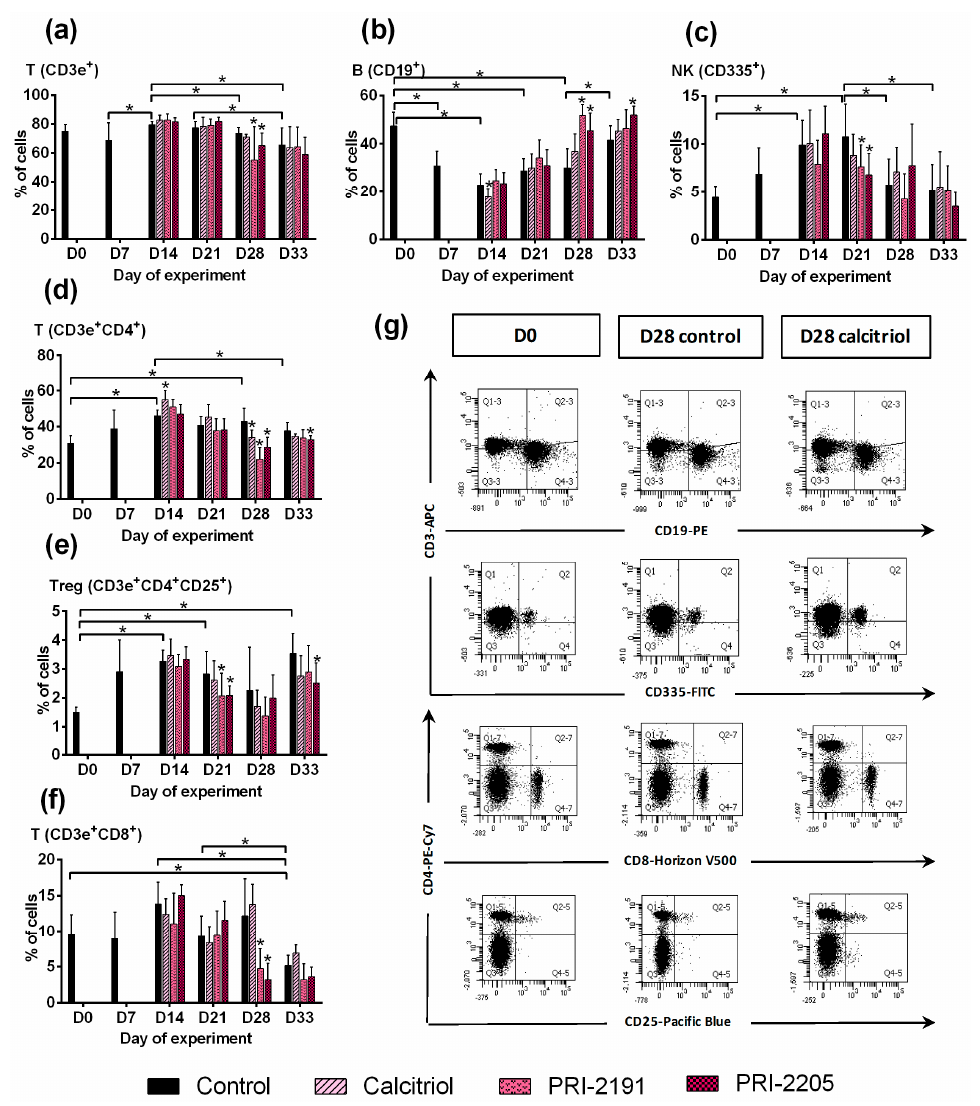
Figure 1. The phenotypes of peripheral blood lymphocytes in mice bearing 4T1 mammary